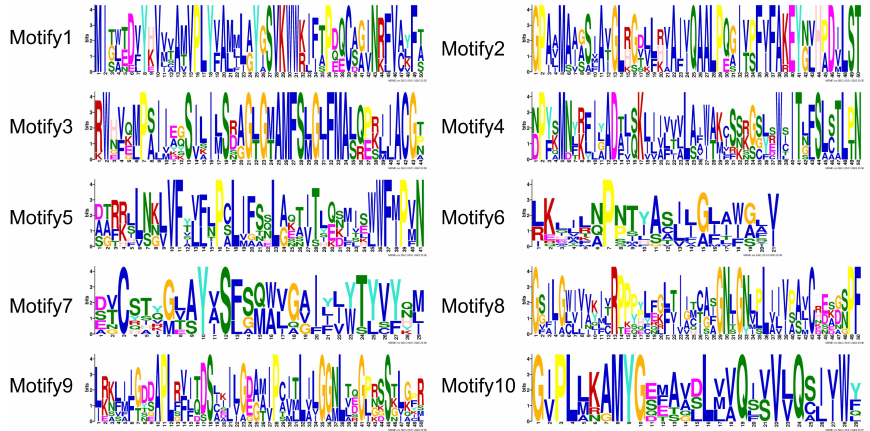
Figure 5. Conserved motif logo analysis. x -axis shows the order of amino acid sequence arrangement, and height is the relative frequency of each amino acid at that position; y -axis shows the height of the amino acid sequence stack, indicative of sequence conservation at that position.